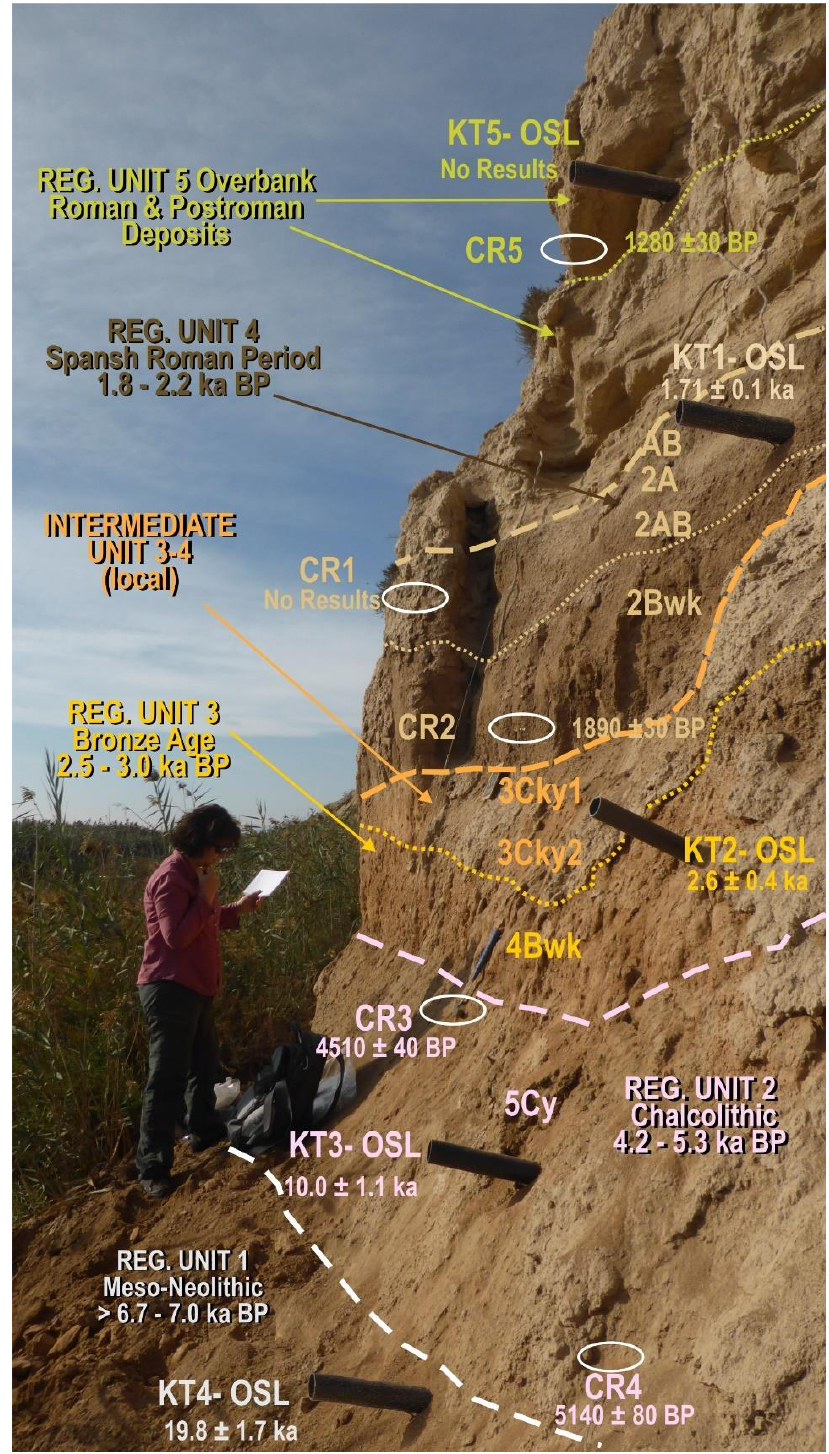
Figure 2. Pedo-sedimentary sequence of the Holocene filling of the Guadalentin Depression at the section of Karting Espuña (south Totana; Figure 1). The location of samples for OSL (KT1 – KT5) and radiocarbon dating (CR1 – CR4) are displayed as well as the upper and lower limits (dashed lines) of the sedimentary units defined in the Guadalentín Depression with the bracketed radiocarbon calibrated ages (BP) proposed by Silva et al. (2008). The paleosol horizon sequence studied in this paper is also displayed in the profile: AB-2A-2AB-2Bwk-3Cky1-3Cky2-4Bwk-5Cy. Note differentiation by colors of sedimentary units and corresponding soil horizons.